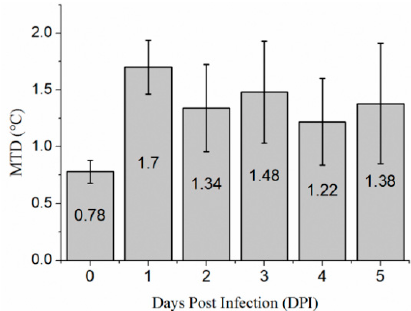
Figure 5. The maximum temperature difference (MTD) within leaves before and after infection. 10 leaves inoculated with Sclerotinia sclerotiorum at day zero were counted.